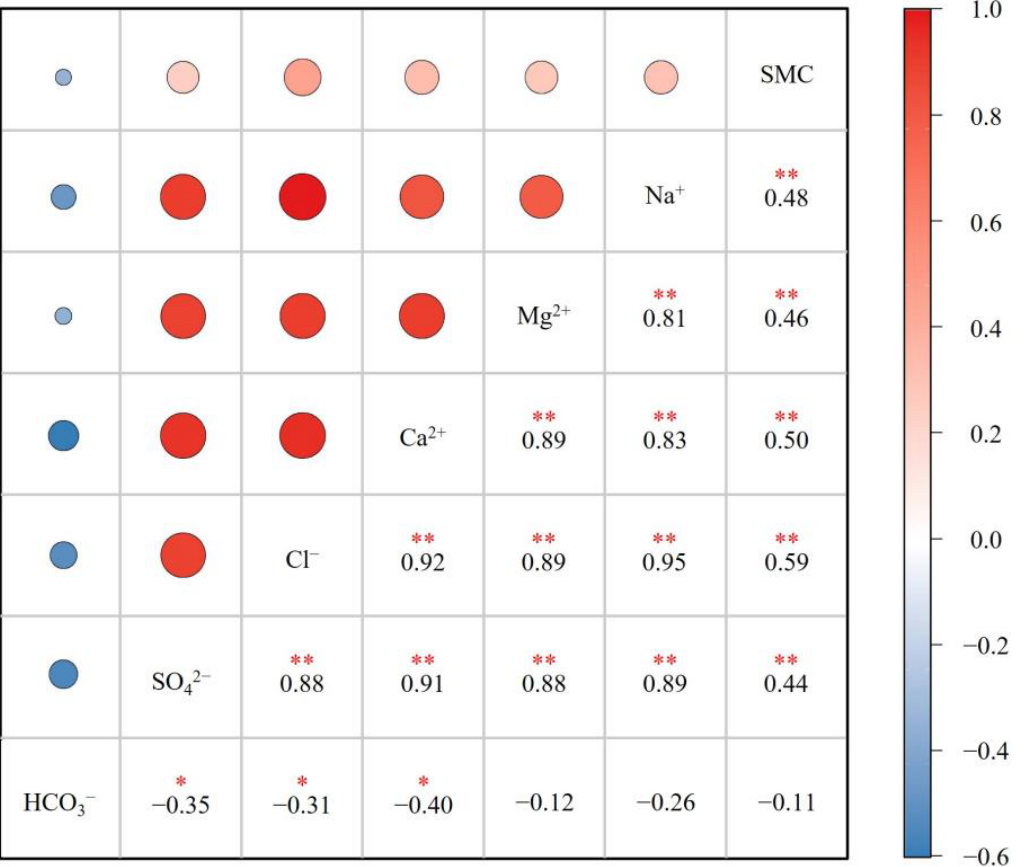
Figure 8. Correlation coefficient matrix of soil soluble ions and soil properties. SMC, soil moisture content. Red denotes a positive correlation and blue denotes a negative correlation. **, p < 0.01; *, p < 0.05.